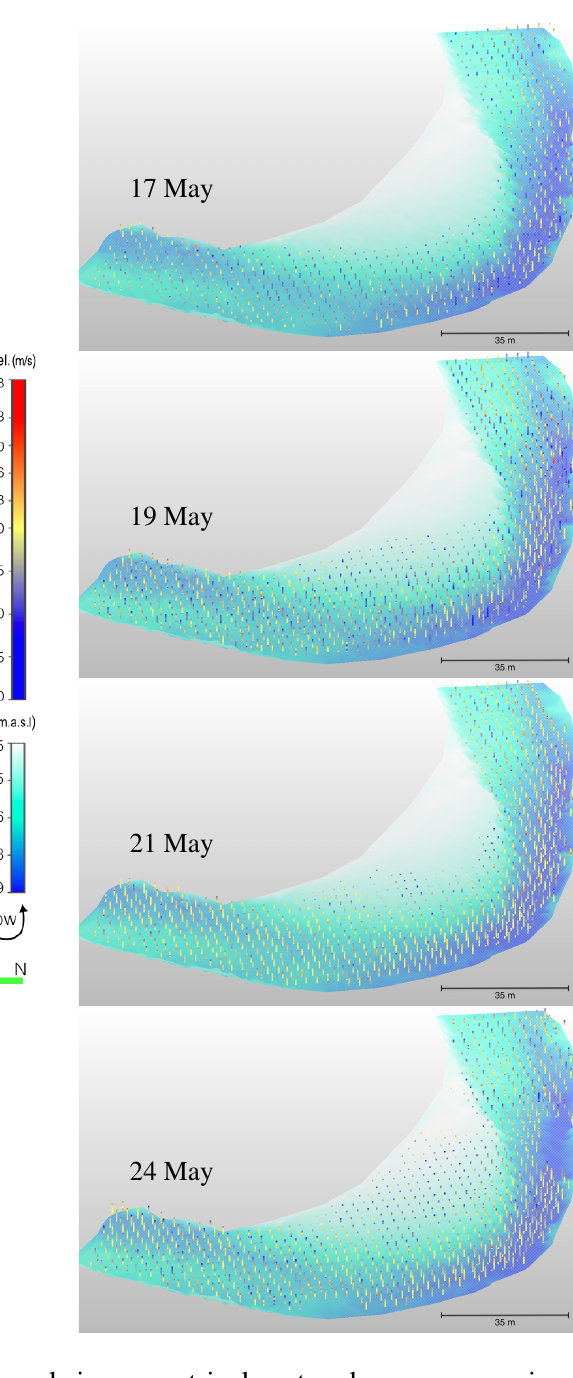
Figure 11. Vertical flow velocities. The color scale is symmetrical centered on zero, meaning horizontal flow. Positive values indicate upwards flow motion (upwelling), and negative values indicate downwards flow motion (downwelling). The Z-axis is exaggerated by a factor of two. The river bed model of 23 May is shown for spatial